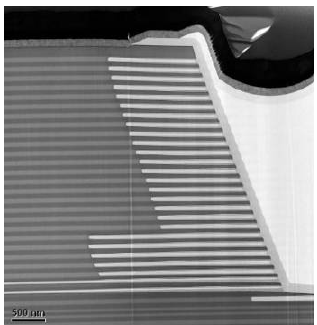
Fig. 4 | TEM image of the VCSEL with double-confined oxide